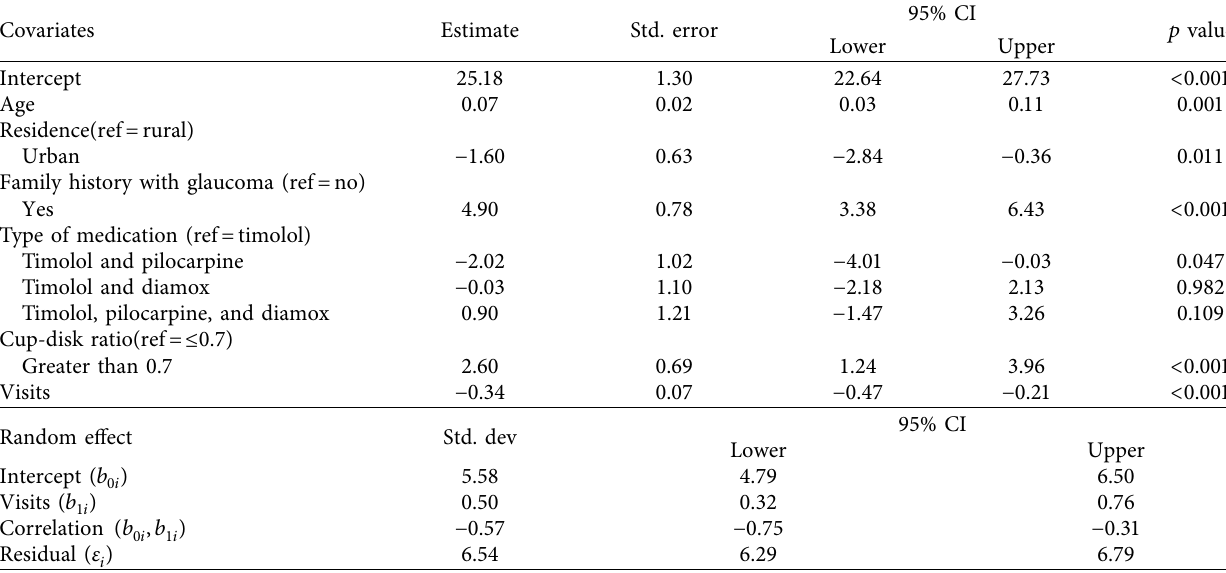
Table 5: Result of the final linear mixed model for glaucoma